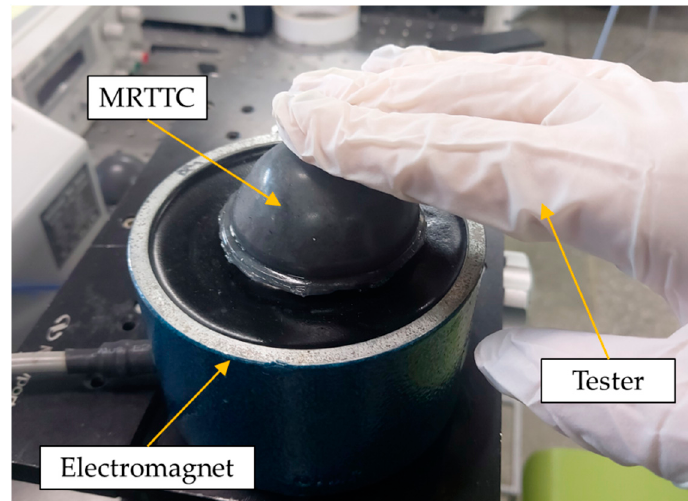
Figure 15. Apparatus for the psychophysical testing.